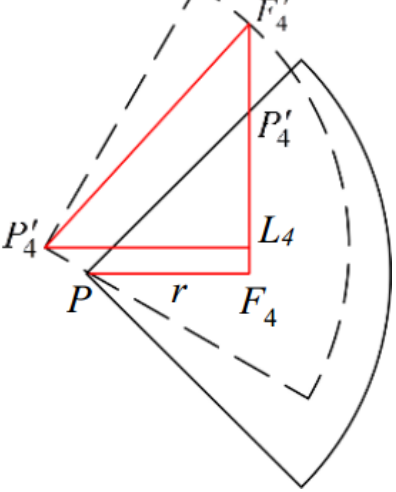
Figure 10. Two reachable area on the ground and increased stride length of leg 4 before and after trunk twisting when P 4 N 4 < r < P 4 H 4 . Where F 4 is the original foothold, F (cid:48) after trunk twisting and P (cid:48)